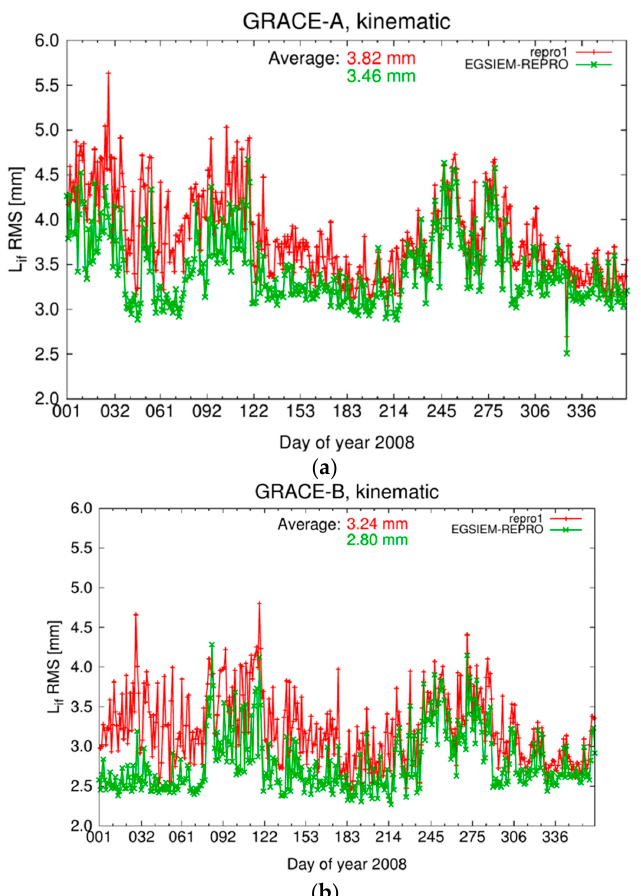
Figure 14. ( a ) RMS of ionosphere-free carrier-phase residuals of kinematic precise orbit determination (POD) for GRACE-A . ( b ) RMS of ionosphere-free carrier-phase residuals of kinematic precise orbit determination (POD) for GRACE-B. The numbers indicate the average RMS values over the entire year. In both figures values in red were calculated using the GPS orbits and clocks from CODE’s contribution to the first IGS reprocessing campaign (repro1), while the values in green present the results obtained with EGSIEM-REPRO products.